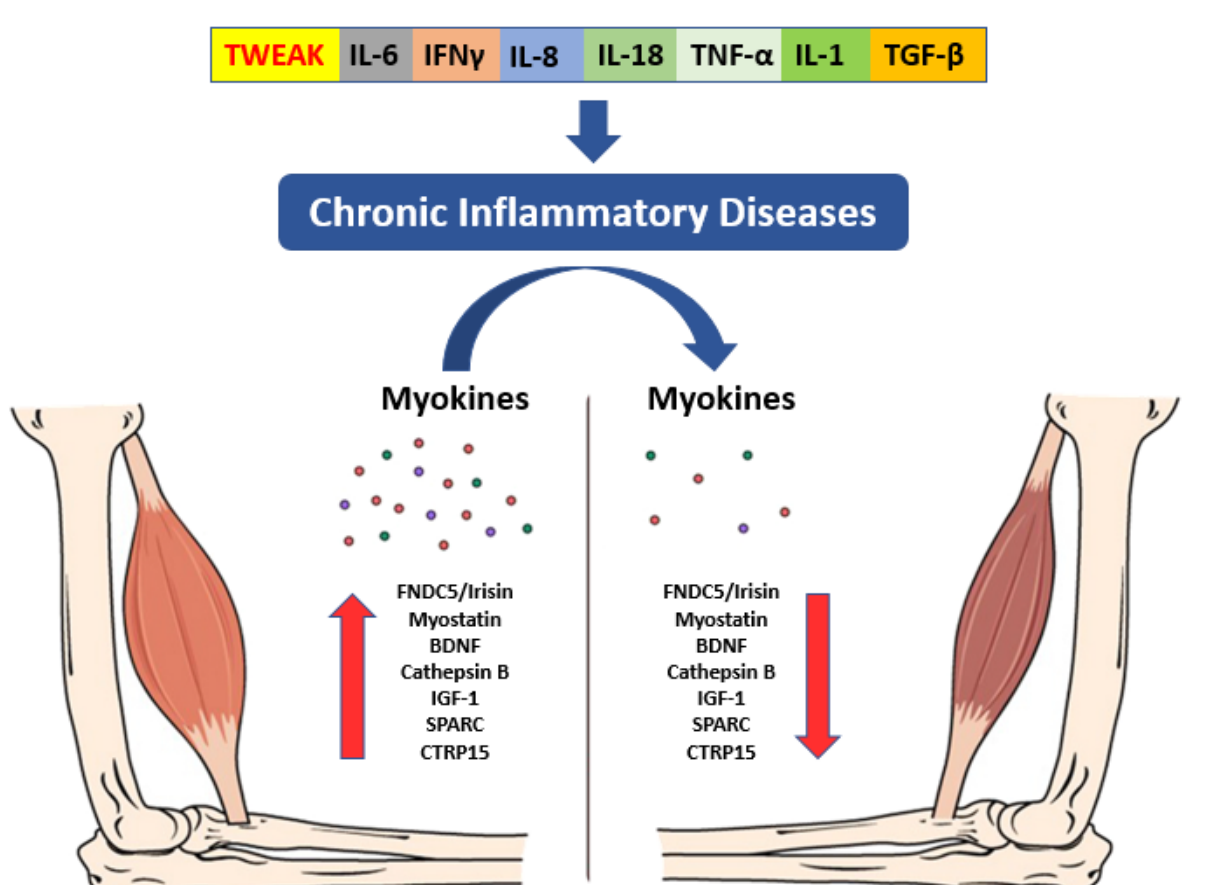
Figure 5. Cytokines released in ischemic stroke generate chronic inflammatory disease with a subsequent decrease of myokines secretion from skeletal muscle resulting in the development of sarcopenia. Upregulation of proinflammatory cytokine production crossing the blood brain barrier (BBB) leads to the imbalanced secretion of myokines in the skeletal muscles and muscle memory impairment. For instance, low IL-6 can activate satellite cells and the regeneration mechanism of myotube, while high IL-6 levels induce muscle tissue wasting through gp130 trans-signaling.